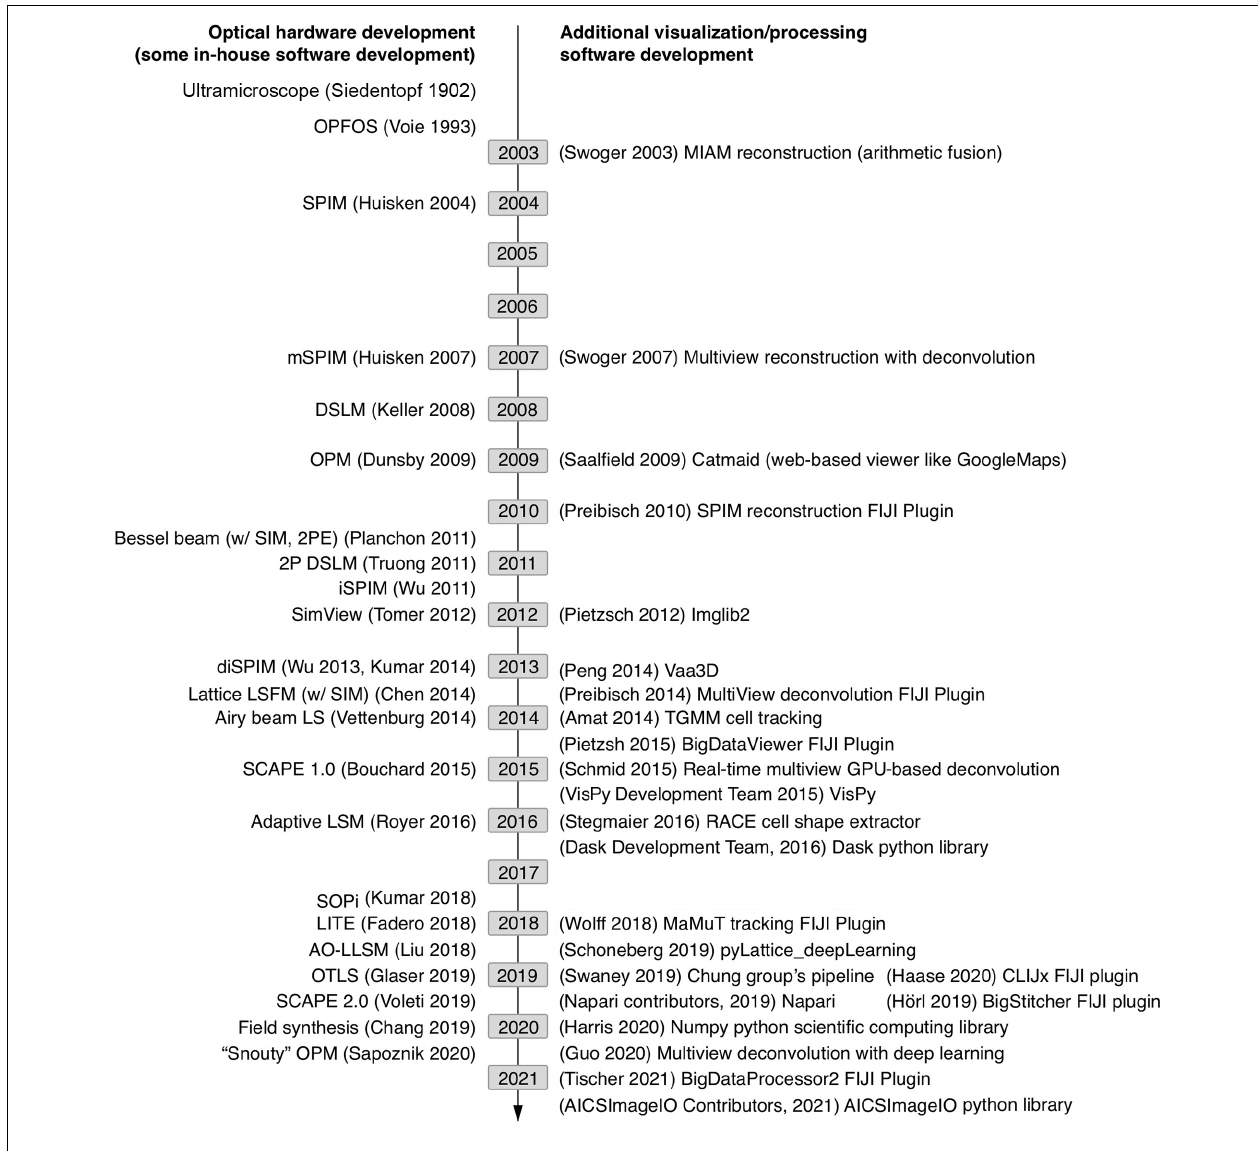
FIGURE 1 | Timeline of sampled light-sheet microscopy optical hardware development and processing software across a variety of applications. As unique species of light-sheet microscopes have been developed, unique analysis solutions have been